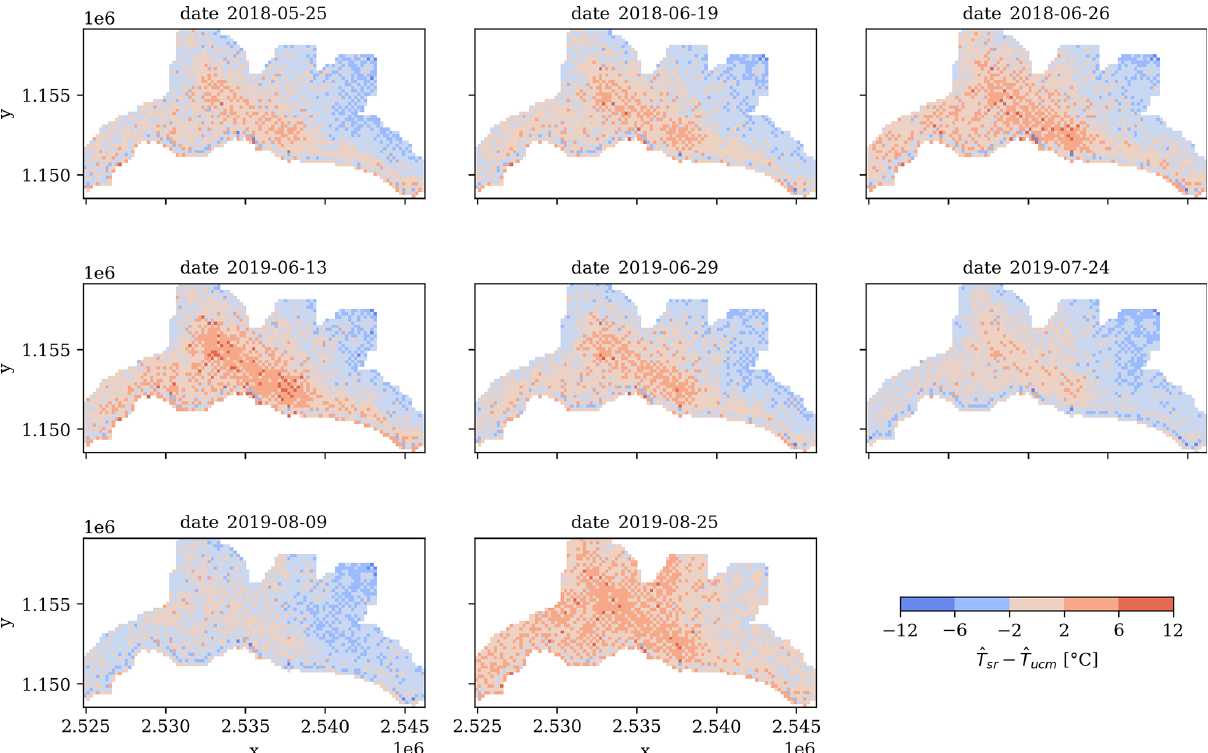
Figure 6. Maps comparing the difference between the T air predicted by the spatial regression ˆ T sr and the InVEST urban cooling model ˆ T ucm for the eight dates (see Appendix